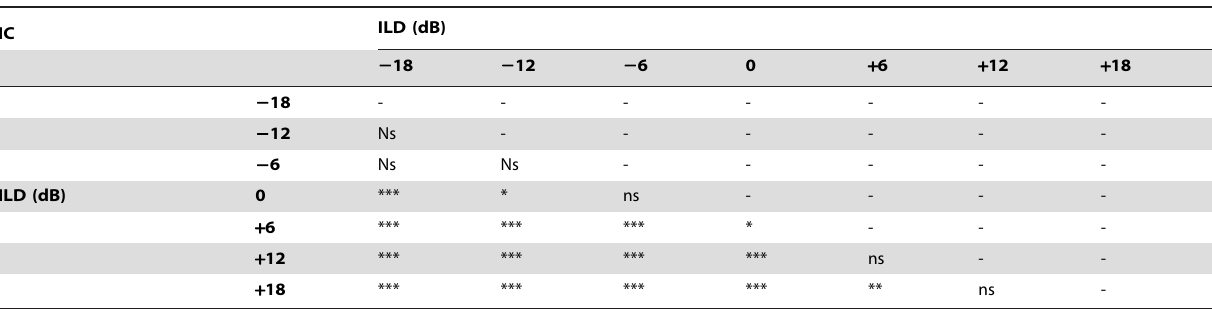
P-value table computed from the BOLD signal ratios measured from the inferior colliculus (IC) of all animals. The symbol *** indicates p , 0.001. In general, the ratios measured at negative ILDs are statistically significantly greater than those measured at 0dB and positive ILDs (p ,